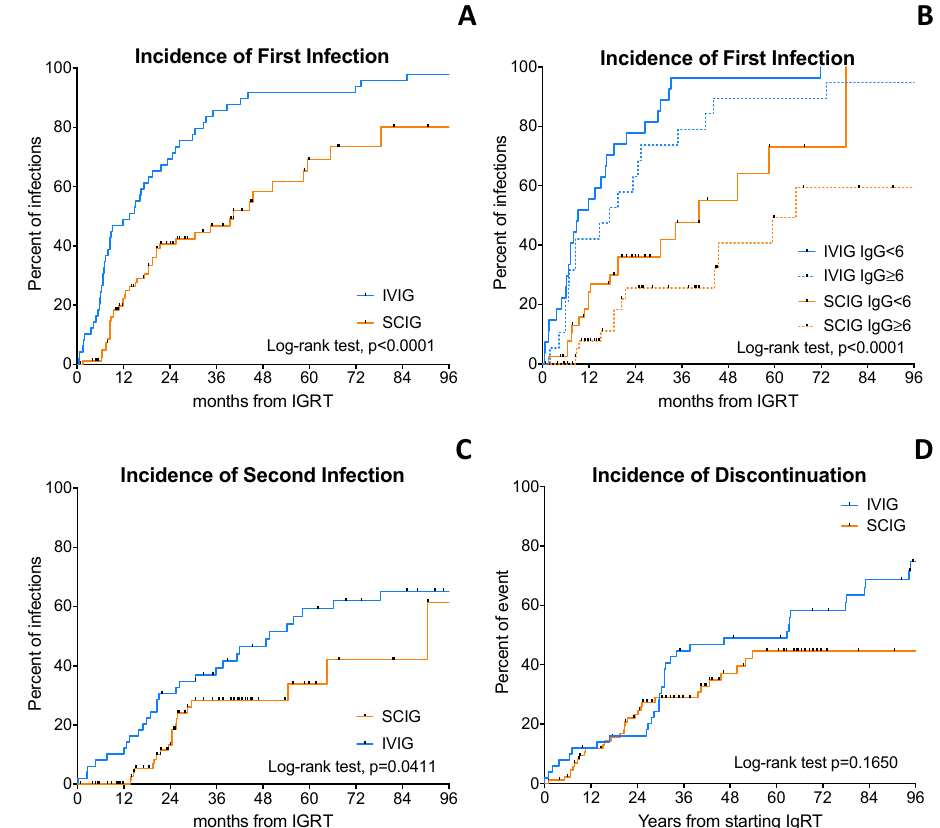
Figure 2. Cumulative incidence of infections and discontinuation. The upper panel on the left ( A ) shows the Kaplan–Meier curves of time to first infection in patients treated with intravenous immunoglobulins (IVIG) or subcutaneous immunoglobulin (SCIG). The upper panel on the right ( B ) shows the Kaplan–Meier curves of time to first infection in patients IVIG or SCIG, according to serum IgG levels. Patients achieving at least 6 g/L of IgG display a longer time to the first infection. In the lower-left panel ( C ) is shown the Kaplan–Meier curves of time to second infection in patients treated with IVIG or SCIG. In the lower-right panel ( D ) is shown the Kaplan–Meier of the cumulative incidence of discontinuation in patients treated with IVIG or SCIG. Log-rank test was used to compared survival curves.